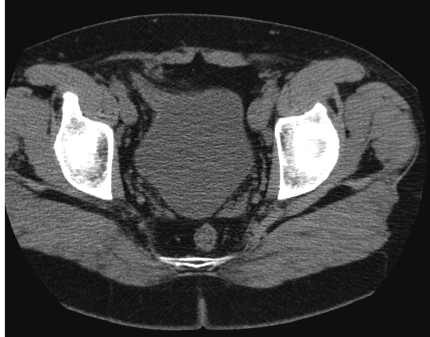
Figure 1: Noncontrast CT: right inguinal hernia containing the bladder